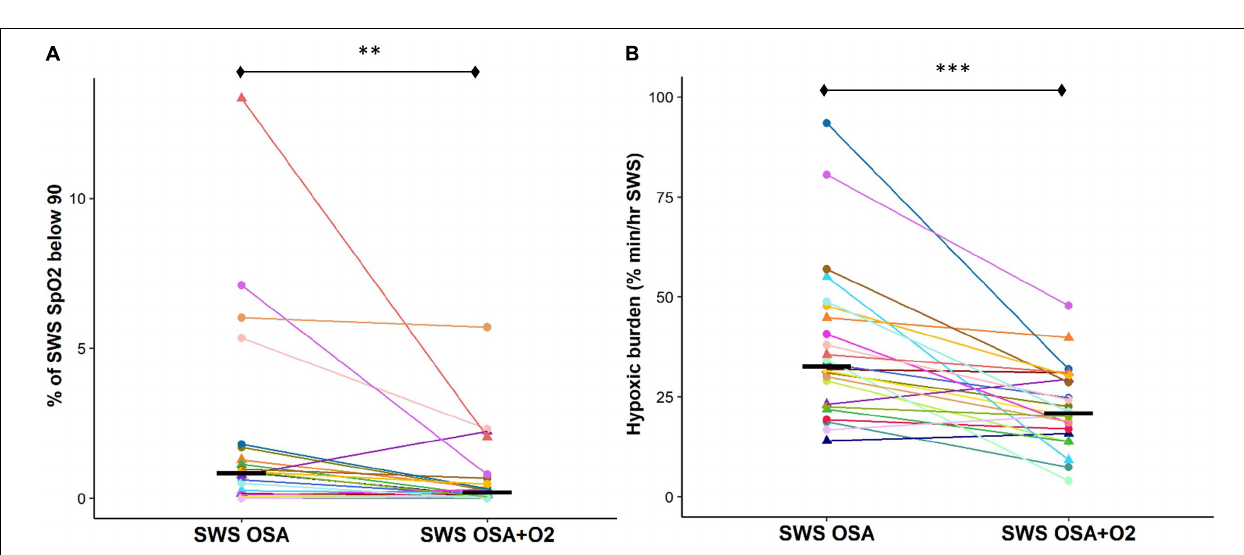
FIGURE 2 | Supplemental O 2 during CPAP withdrawal results in less OSA event-related SpO 2 desaturation. The OSA event-related SpO 2 desaturation is significantly reduced with the addition of supplemental oxygen as shown by an elevated lowest desaturation level during SWS (A) and a reduced number of oxygen desaturations ≥ 3% per hour of SWS (B) . All 24 participants are represented by different colors with a triangle indicating female. Mean values for each condition are indicated with a solid black line. n.s., not significant; ∗∗∗∗ p < 0.0001, ∗∗∗ p < 0.001, ∗∗ p < 0.01 and ∗ p < 0.05.